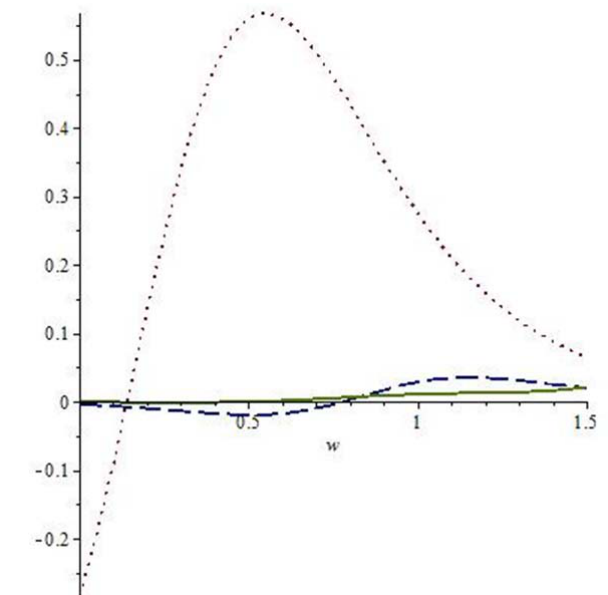
Figure 4. Error obtained with (cid:1834)(cid:4666)(cid:1875)(cid:4667) when (cid:1858) (cid:3404) (cid:3398)(cid:4666)(cid:1876) (cid:3397) (cid:1877)(cid:4667) and ϵ = 0.5, 0.25 and